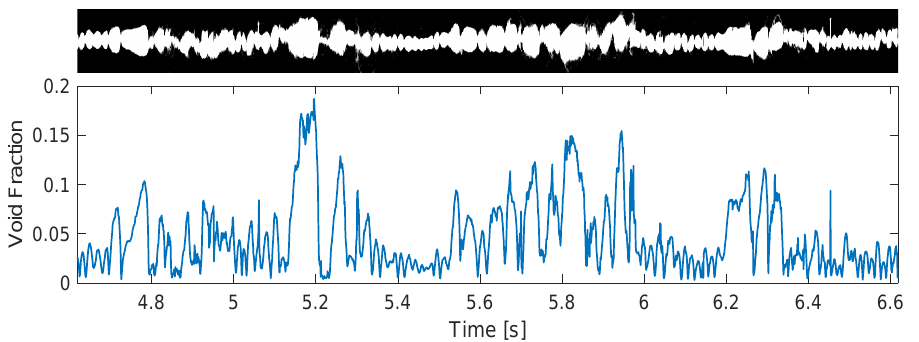
Figure 15. Gas–liquid distribution ( top ) and volumetric fraction of air ( bottom ) of an intermittent column reconstructed based on camera recordings for a water flow rate of 80 L/min and an air flow rate of 70 Ln/min. The two images correspond to the same data and share the same time axis. Gas is represented in white and liquid in black in the images.